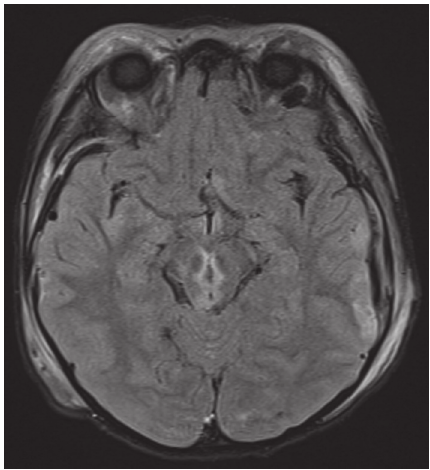
Figure 4: Axial FLAIR MRI showing multiple injuries in the tegmentum, tectum, and periaqueductal parenchyma of the mid- brain, with involvement of the right cerebral peduncle, the right side of the pons, and the right middle cerebellar